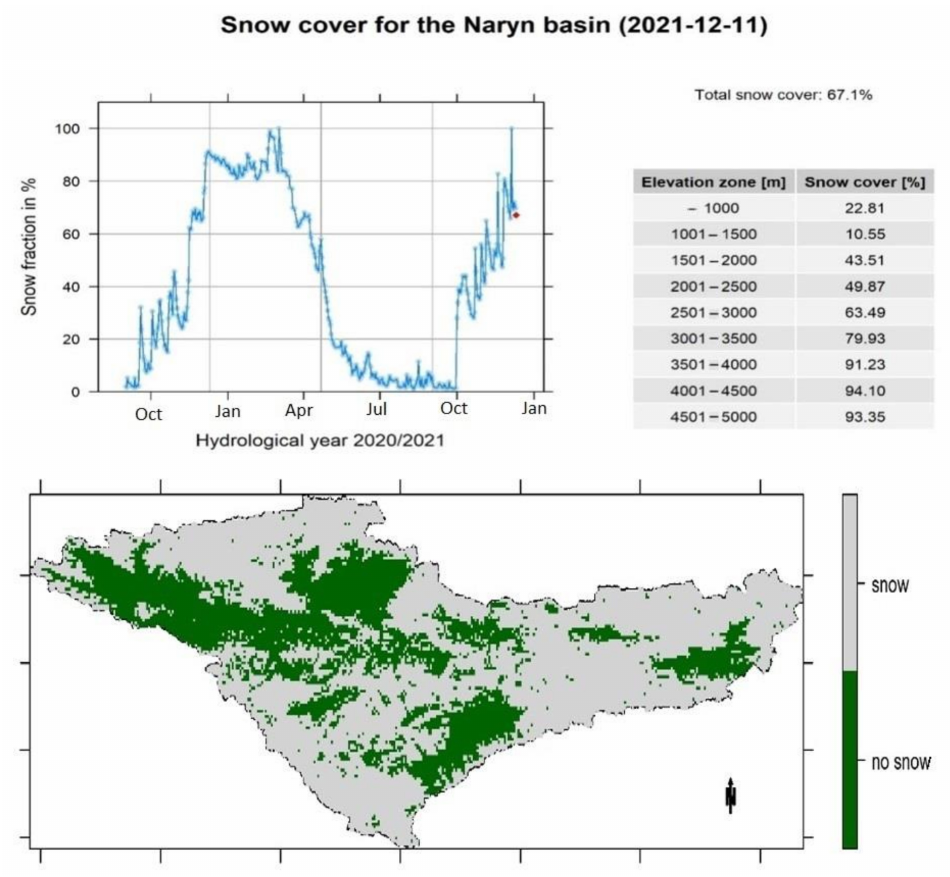
Figure 6. Spatial map of snow coverage in the Naryn river basin on and temporal evolution of snow cover